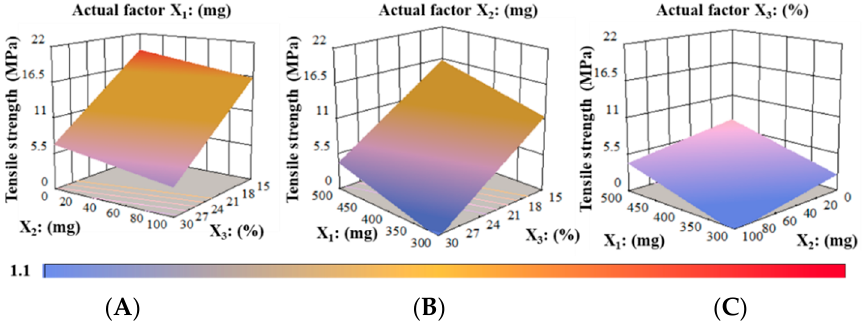
Figure 5. 3D surface models describing the influence of ( A ) PUL (X 1 ), ( B ) MTX (X 2 ), and ( C ) PG (X 3 ) on tensile strength (Y 3 ) of